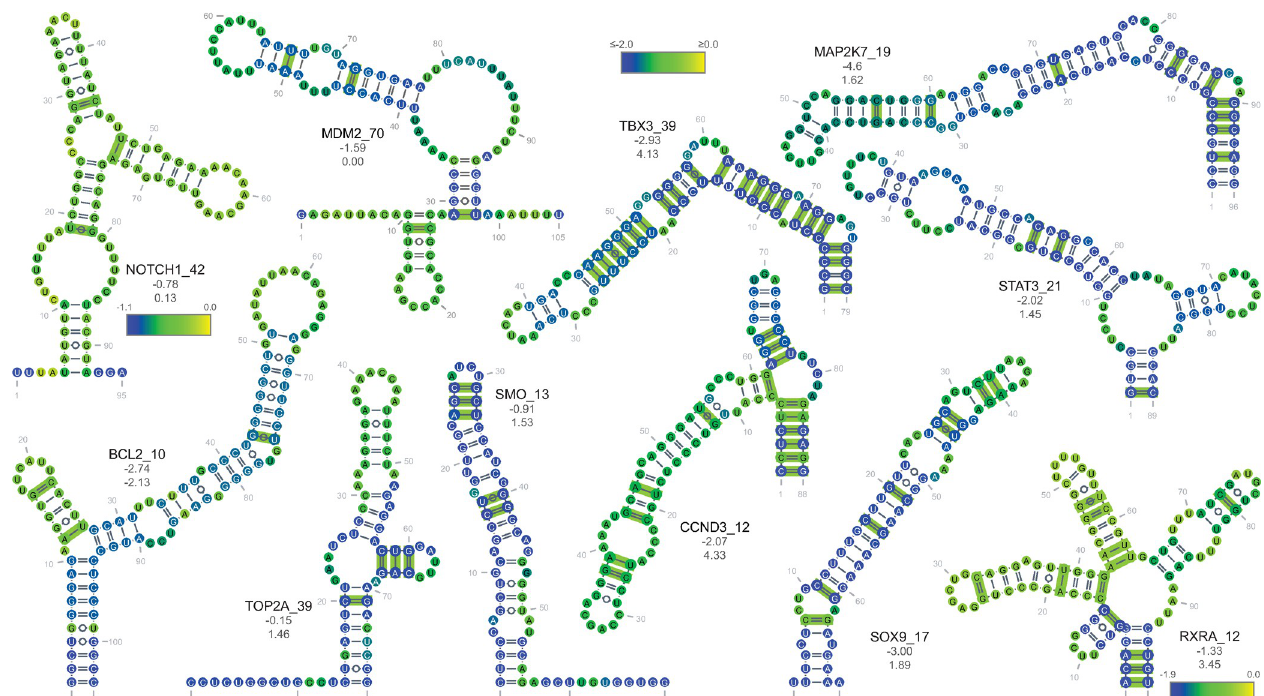
Fig 7. Examples of 3 0 UTR structures. Covarying base pairs are denoted in green (R-scape). The gene symbol and structure number are shown next to the secondary structure diagram. Zscore average per structure indicated below the name with the Zcm below that. Scale indicates per nucleotide average z-score for all calculated windows. The structure z-score (not the average of per nucleotide windows) and the Zcm are provided under the structure names, respectively.